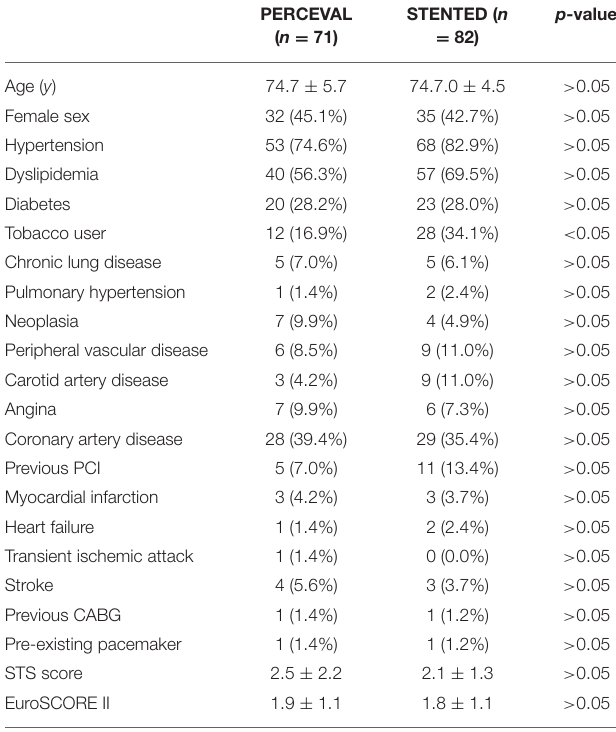
TABLE 1 | Patients’ baseline characteristics.